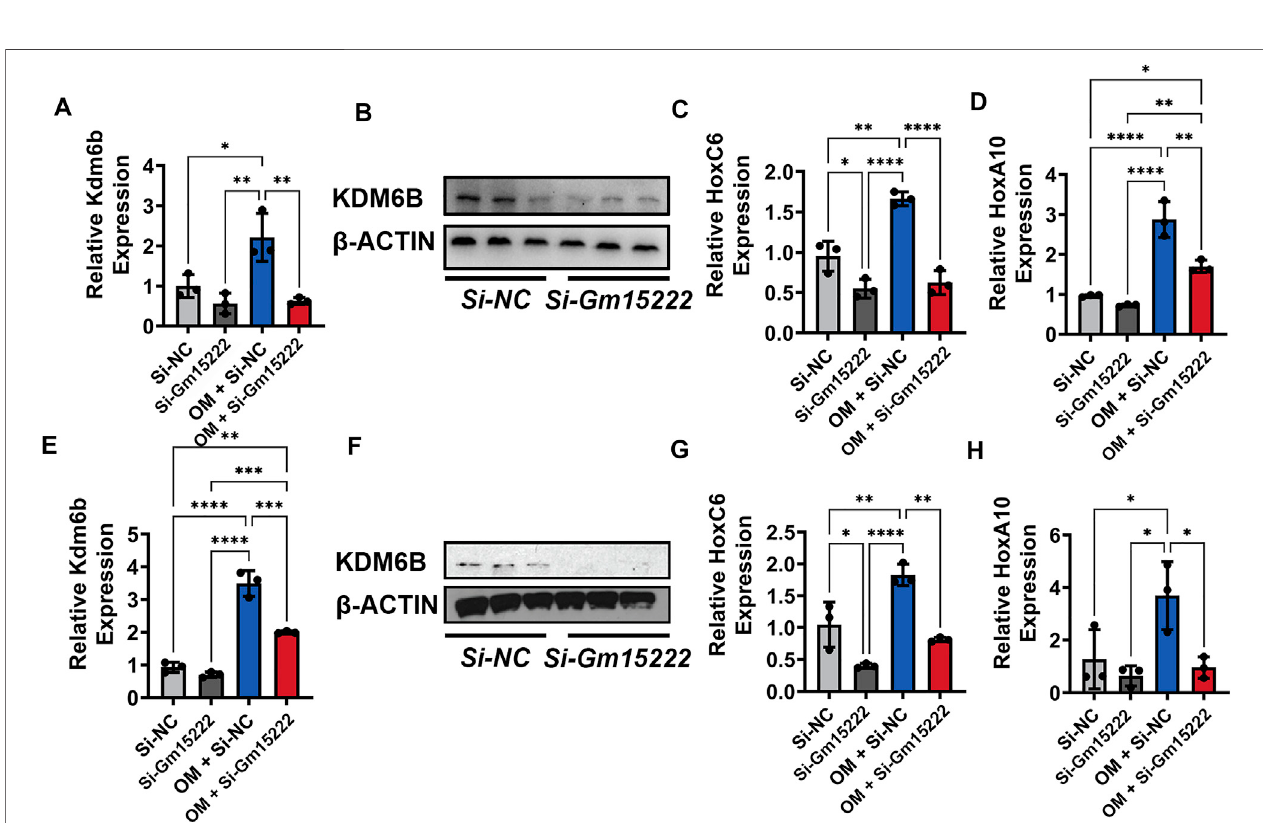
FIGURE 4 | Gm15222 regulates the expression of Kdm6b and its downstream Hox gene family. (A) The silence of Gm15222 inhibited KDM6B expression, as detected by qRT-PCR in MC3T3-E1 cell line treated with or without mineralization medium and Si-Gm15222, n = 3. (B) The silence of Gm15222 impaired KDM6B protein expression in the process of mineralization, as detected by Western blot in MC3T3-E1 cell line treated with or without mineralization medium and Si-GM15222. (C) The silence of Gm15222 impaired HOXC6 expression, as detected by qRT-PCR in MC3T3-E1 cell line treated with or without mineralization medium and Si- Gm15222. (D) The silence of Gm15222 impaired HOXA10 gene expression, as detected by qRT-PCR in MC3T3-E1 cell line treated with or without mineralization medium and Si-Gm15222, n = 3. (E) The silence of Gm15222 inhibited KDM6B expression, as detected by qRT-PCR in BMSCs treated with or without mineralization medium and Si-GM15222, n = 3. (F) The silence of Gm15222 impaired KDM6B expression in the process of mineralization, as detected by Western blot in BMSCs treated with or without Si-Gm15222, n = 3. (G) The silence of Gm15222 impaired HOXC6 gene expression, as detected by qRT-PCR in BMSCs treated with or without mineralization medium and Si-Gm15222. (H) The silence of Gm15222 impaired HOXA10 expression, as detected by qRT-PCR in BMSCs treated with or without mineralization medium and Si-Gm15222, n = 3. Data were shown as mean ± S.D., one-way ANOVA with Tukey ’ s post hoc test was used to test those data. * p < 0.05; ** p < 0.01; *** p < 0.001; **** p < 0.0001.